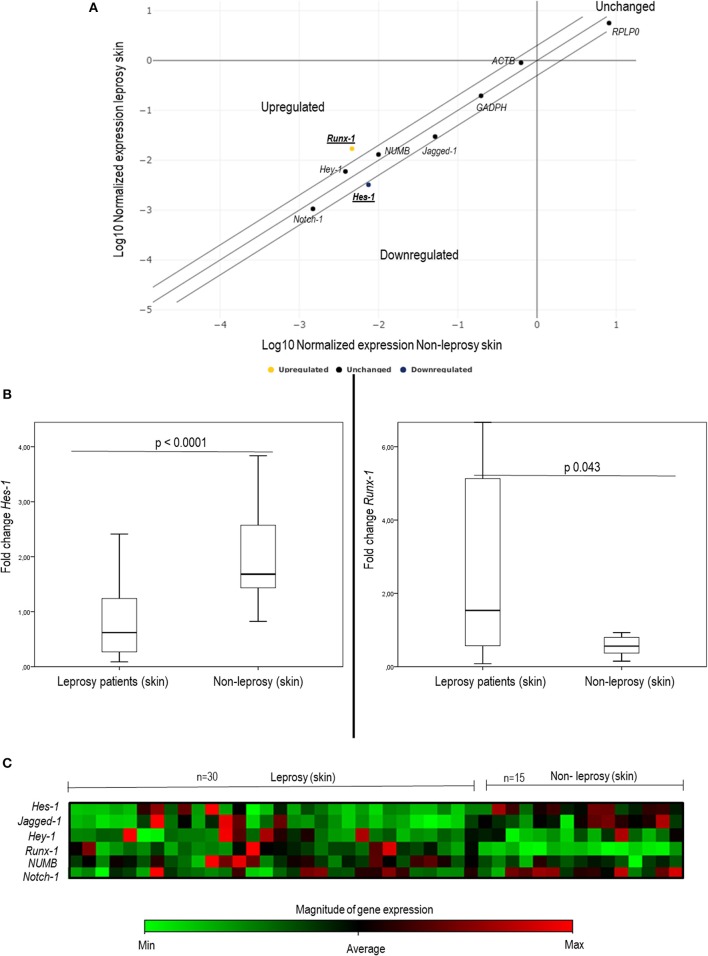
Changes in the expression of some components of the Notch signaling pathway in leprosy skin vs. non-leprosy skin using q-PCR. (A) The dispersion chart shows non-significative changes in genic expression (≤ 2) for Notch-1, Jagged-1, Hey-1, and Numb (black dots). Outside of the matrix, Hes-1 and Runx-1 show significant change (≥ 2), and there are significant changes in gene expression (≥2) for Hes-1 (Blue dot - downregulated) and Runx-1 (yellow dot - upregulated). (B) Whisker box charts show lower expression of Hes-1 and an increase in the expression of Runx-1 in leprosy patients vs. non-leprosy (p < 0.05). (C) Heat map shows the gene expression of Hes-1, Runx-1, Notch-1, Jagged-1, Hey-1, and Numb in leprosy and non-leprosy patients. Green tones indicate a downregulated gene, and red tones indicate upregulated genes.